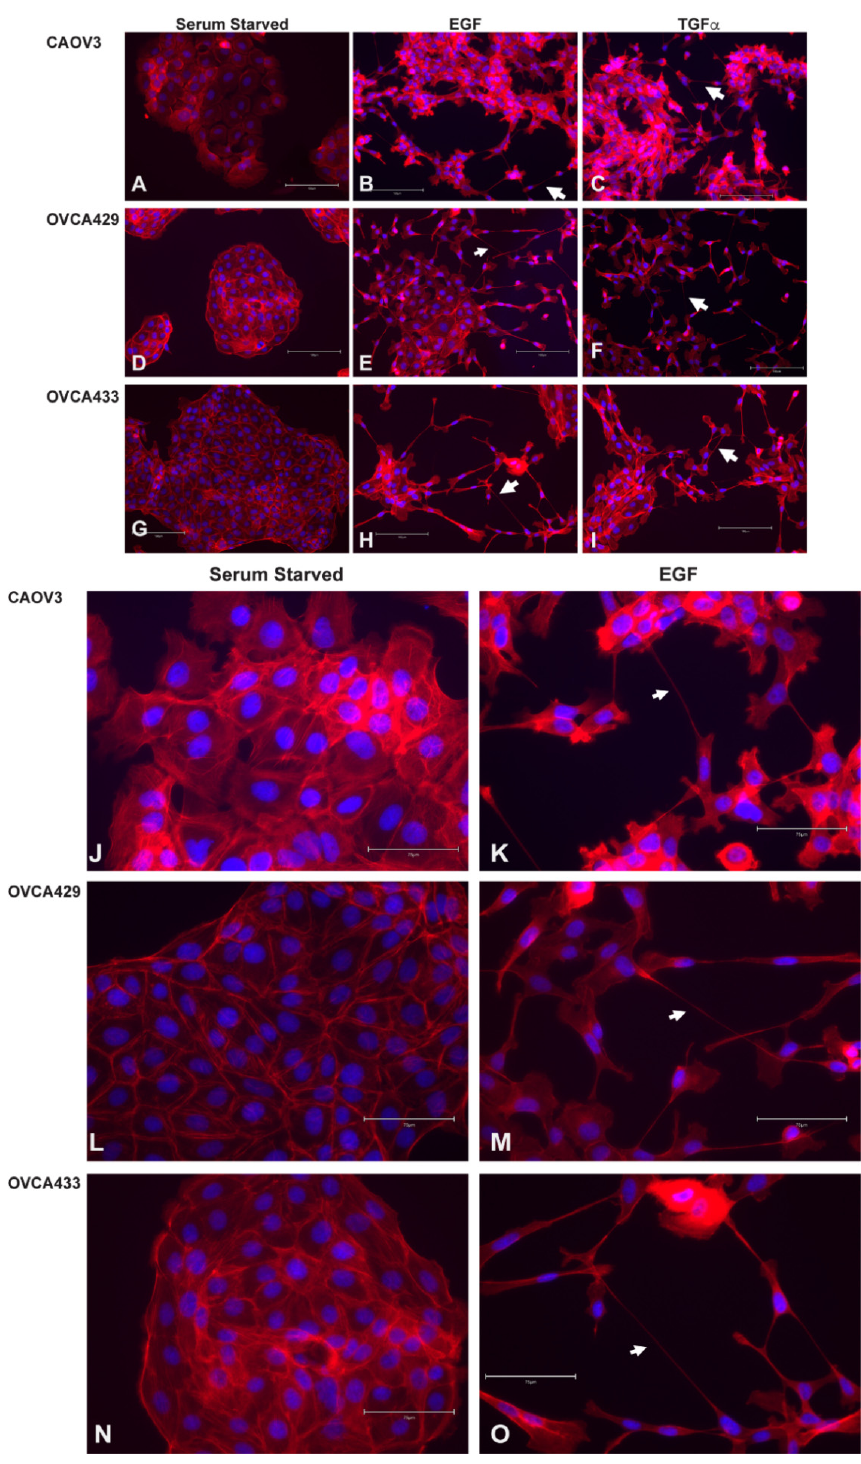
Figure 4. EGF and TGF α induce TnTs in ovarian cancer cell lines. CAOV3 ( A – C , J , K ), OVCA429 ( D – F , L , M ) and OVCA433 ( G – I , N , O ) cells were serum starved for 24 h and then treated with 20 nM EGF for 24 h or 50 ng/mL TGF α for 24 h. Cells were stained with Texas Red Phalloidin to visualize F-actin based structures and DAPI (blue). Arrows denote TnTs. ( A – I ) are 20X original magnification and ( J – O ) are 40X original